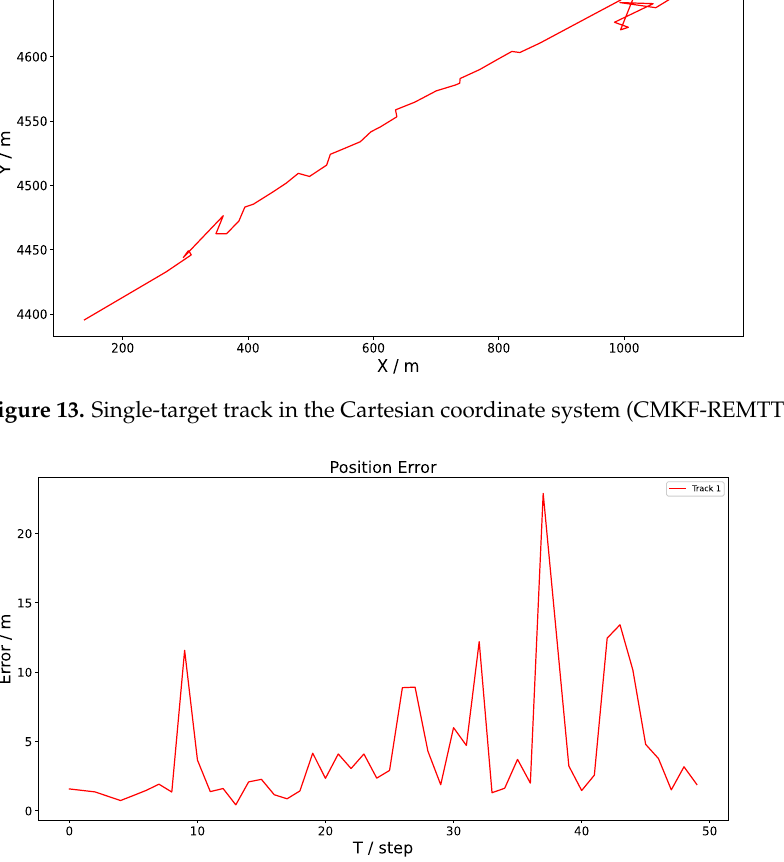
Figure 14. Tracking error between the prediction and actual track (REMTT).